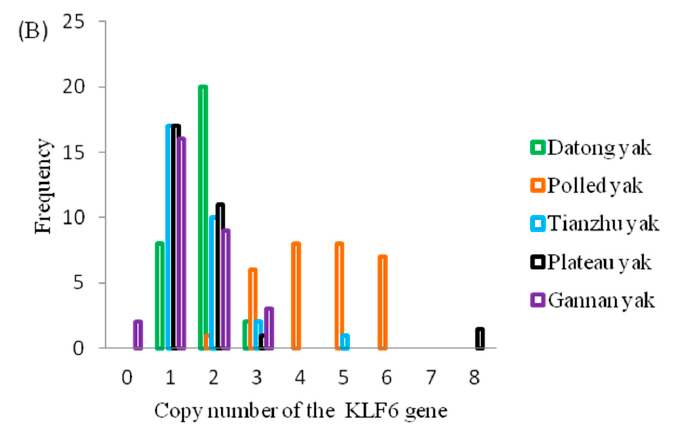
Figure 1. Distributions of CNVs of the KLF6 gene in five yak breeds. ( A ) Scatterplot of CNV distributions of the KLF6 gene in five yak breeds ( n = 30). ( B ) Relative frequency of copy numbers